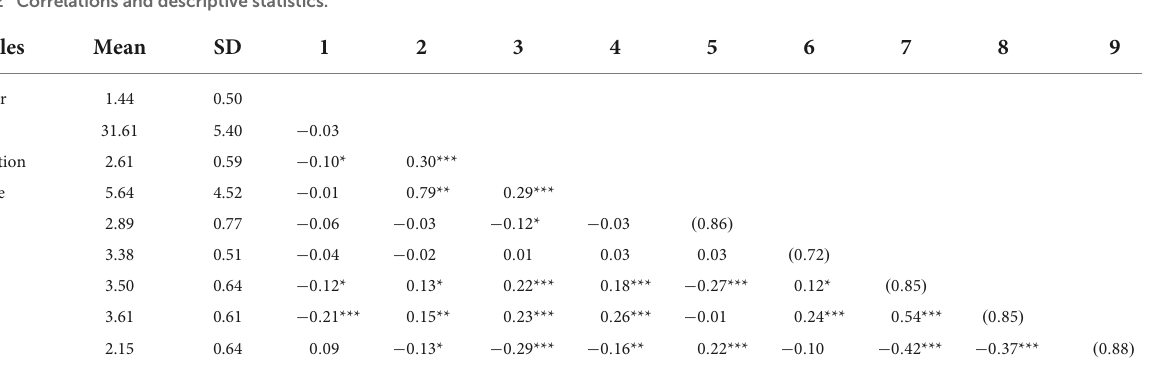
TABLE 2 Correlations and descriptive statistics.